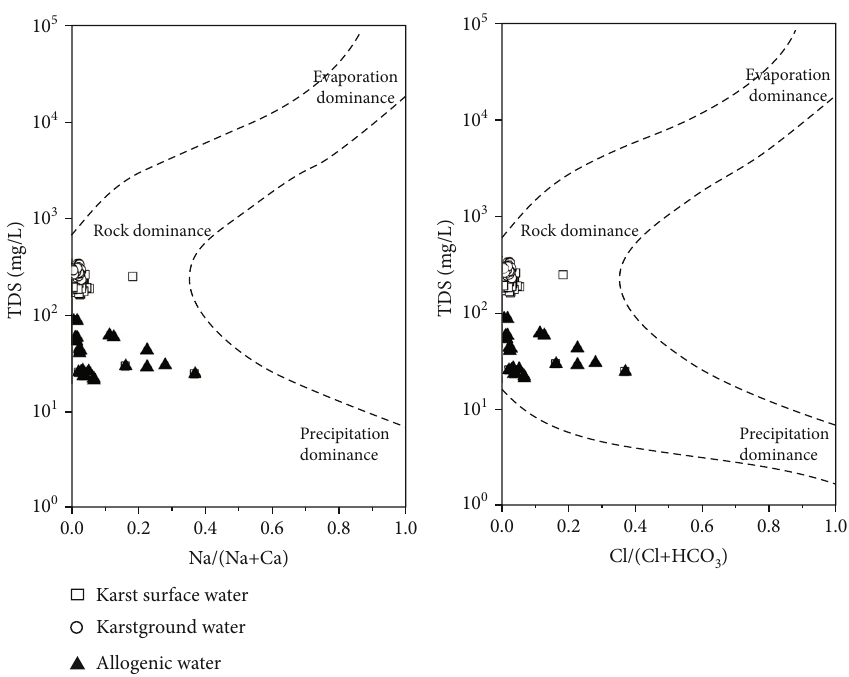
Figure 3: Gibbs graphs of surface and underground waters in Shanmuhe Dolomite